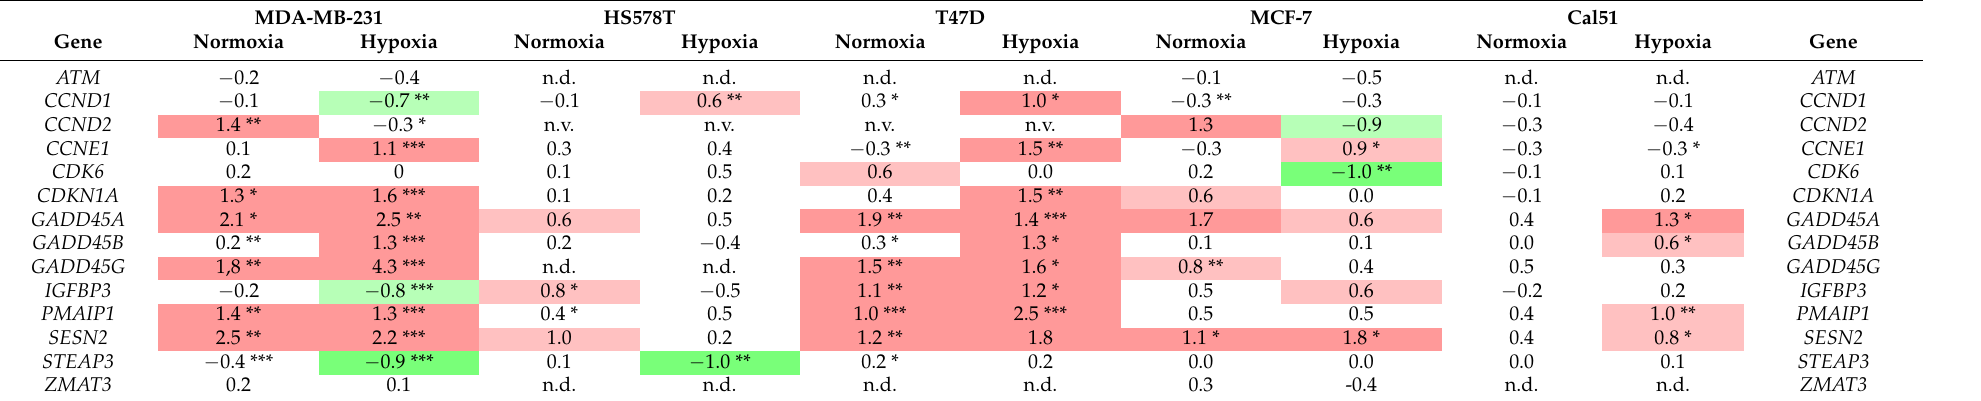
Table 4. Log2-fold-change of gene expression caused by BA treatment referred to DMSO-treated